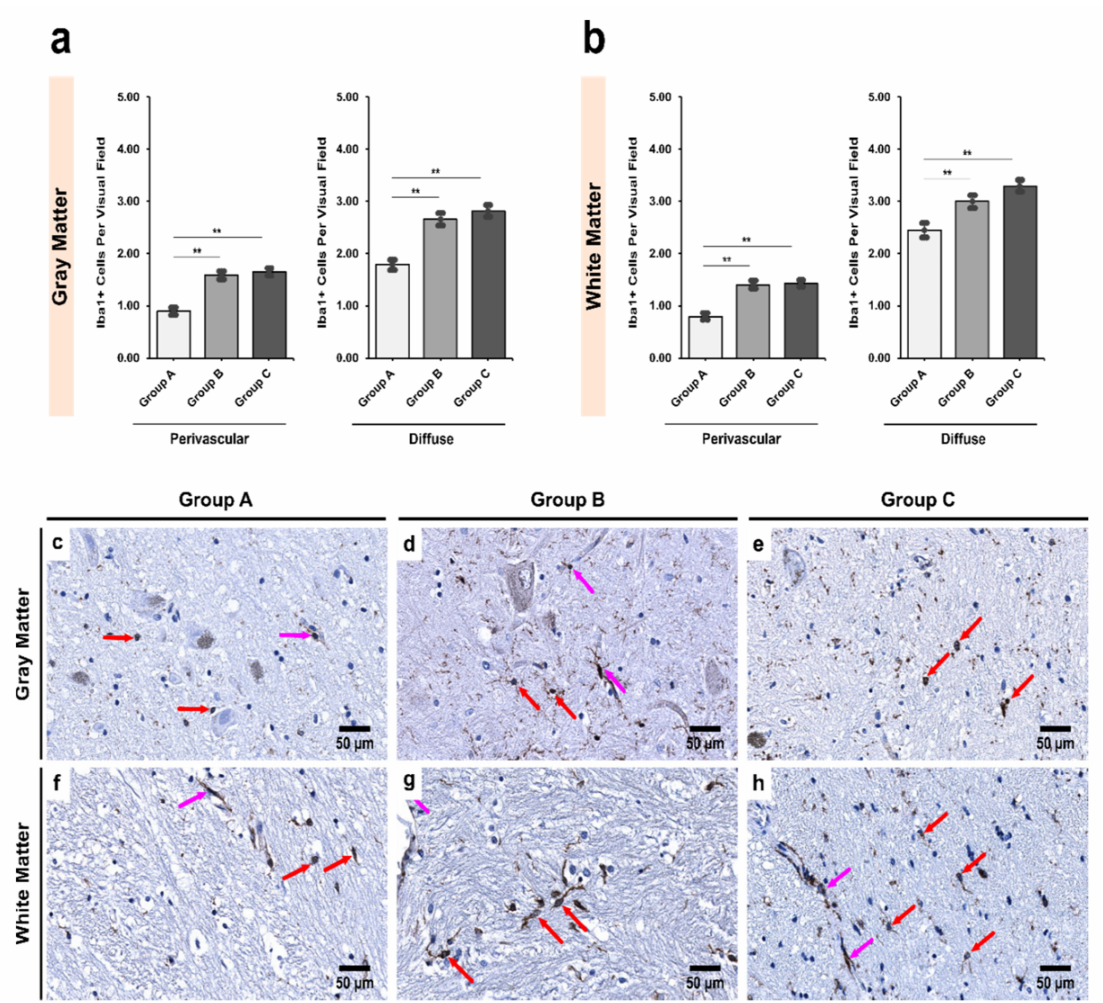
Figure 3. Intergroup analysis of Iba1+ cells per visual field in Pars Compacta (SNpc) for the three studied groups in both ( a ) gray and ( b ) white matter. The analysis was done for both perivascular and diffuse locations. The bar plots indicate the average number of Iba1+ cells ± S.E. (Standard Error) seen per visual field. ** indicates a significant difference between the groups ( p < 0.05 with Bonferroni correction is considered significant). Distribution of Iba1+ cells per visual field in ( c , f ) Group A (controls); ( d , g ) Group B (age-matched alcoholics) and ( e , h ) Group C (non-age-matched alcoholics). Pink arrows indicate perivascular Iba1+ cells while red arrows indicate diffuse Iba1+ cells. Original magnification, 400 × . Scale bars, 50 µ